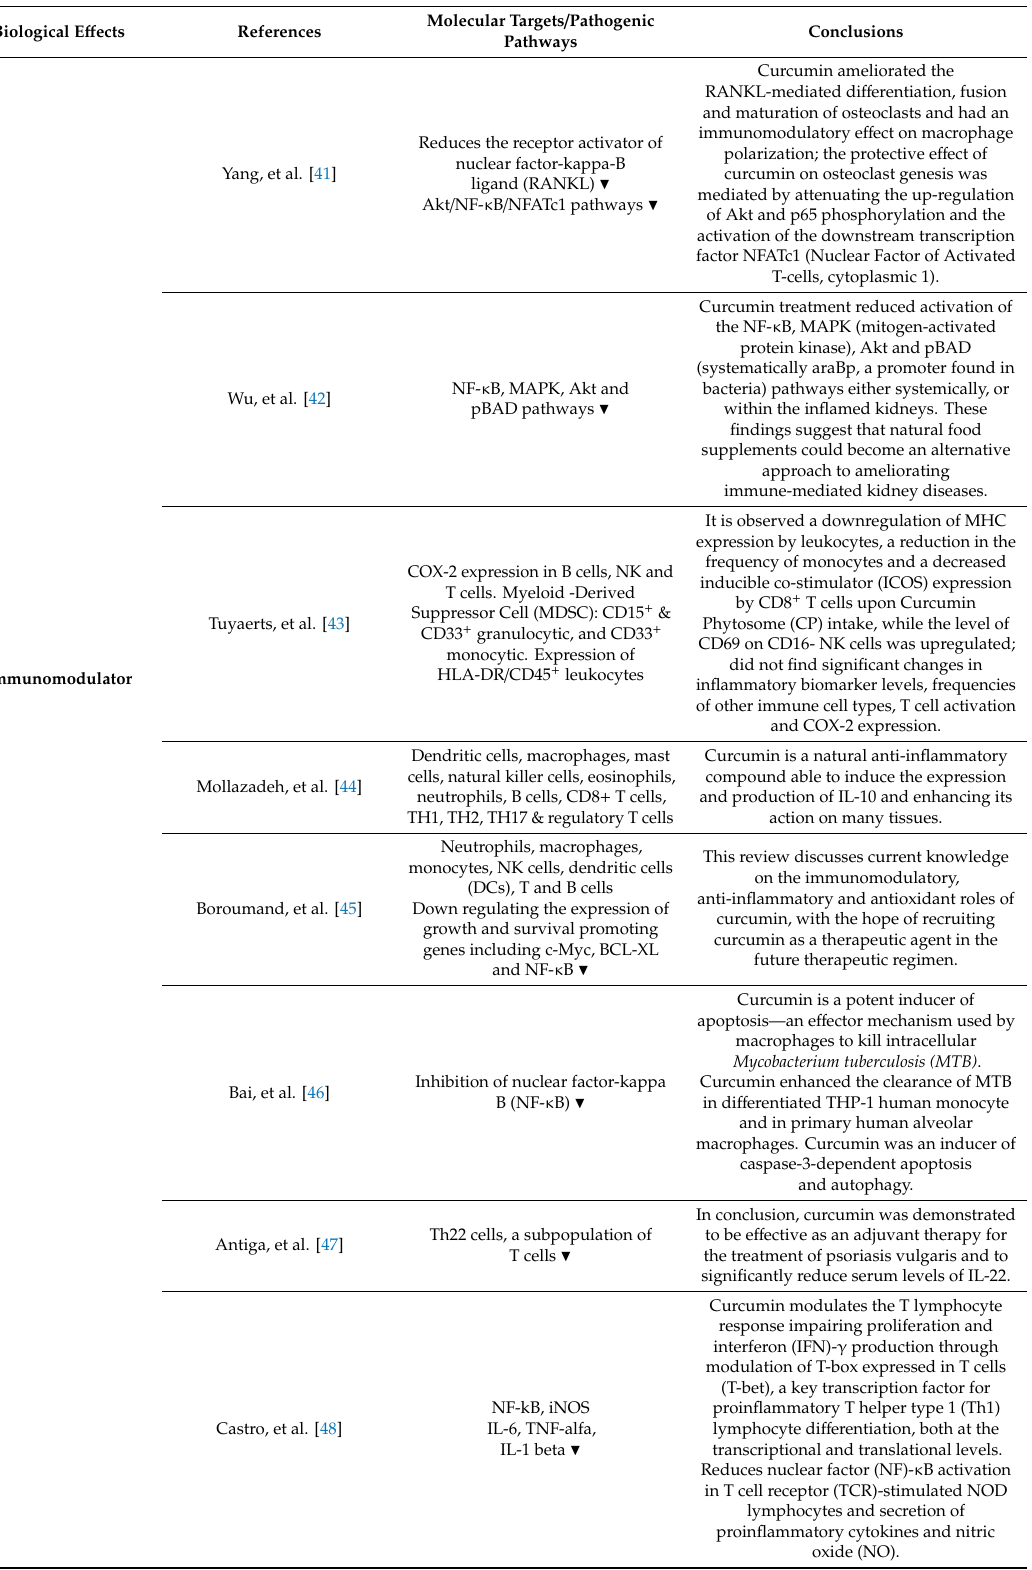
Table 1. Molecular targets and protective e ff ects of curcumin on pathogenic pathways [41–75]. (cid:72) = “decrease”, (cid:78) =